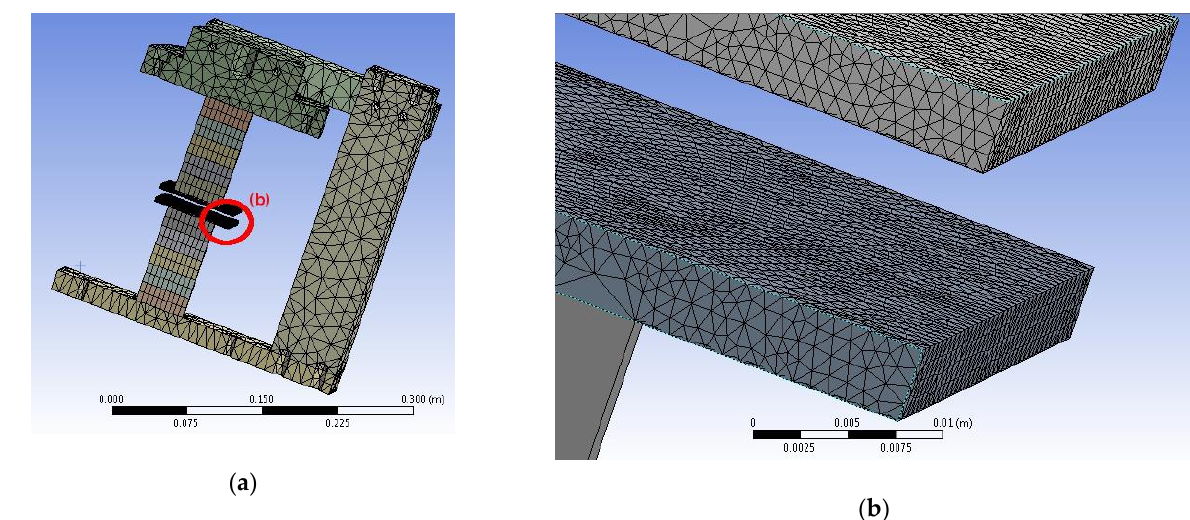
Figure 9. Mesh of finite elements (tetrahedrons, quality 0.748, aspect ratio 2.319, skewness 0.329, orthogonal quality 0.675): ( a ) experimental station; ( b ) densification on the surface of the separators in m .